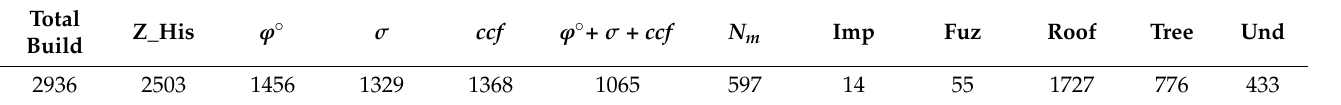
Table 5. Number of points detected in each step of suggested